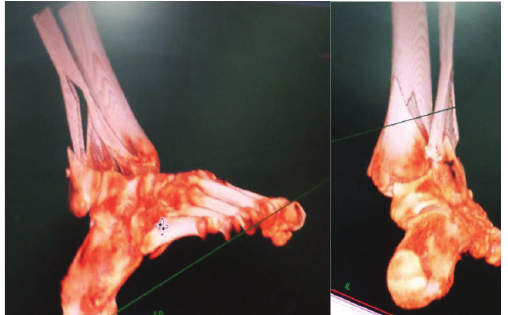
Figure2:Apilonfracturewithamajorposteriormalleolarfragment is seen. Note split of the fibula.